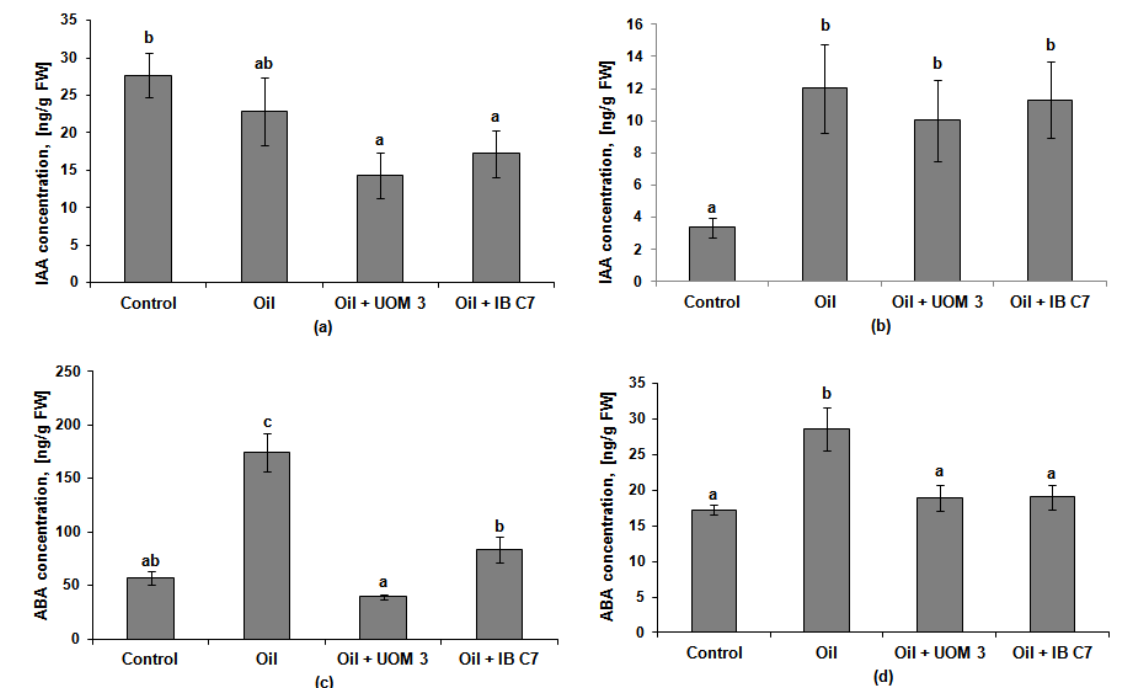
Figure 4. Indole-3-acetic acid (IAA) and abscisic acid (ABA) content in roots (( a , c ), respectively) and shoots (( b , d ), respec- tively) of barley plants. UOM 3 and IB C7, variants of experiments with introduction of Enterobacter sp. UOM 3 and P. hunanensis IB C7, respectively. Statistically different means values for each indicator ( n = 9) are marked with different letters ( p ≤